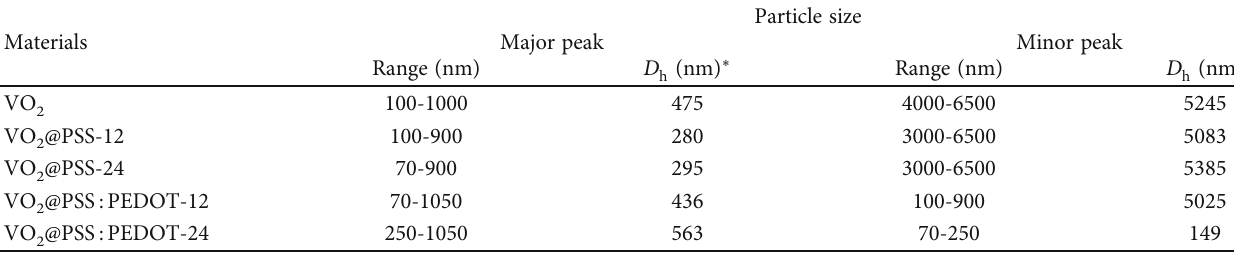
-based particles. 2